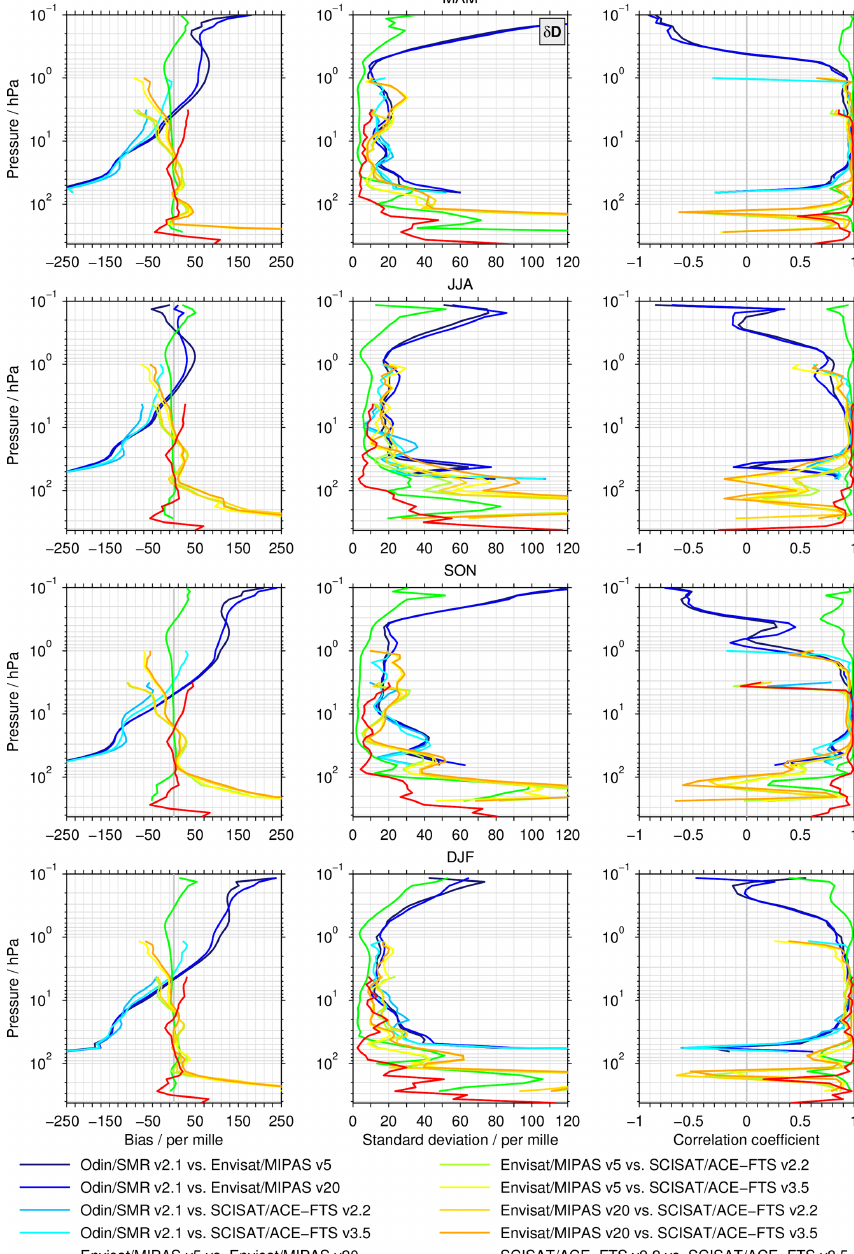
Figure 7. Summary of the seasonal comparisons that were exemplarily shown in Figs. 4 to 6. Here δ D is considered. The left panels show the biases averaged over all latitudes for the individual seasons (different rows), the corresponding de-biased standard deviations are shown in the centre panels, and the correlations between the latitudinal cross sections are given in the right panels .